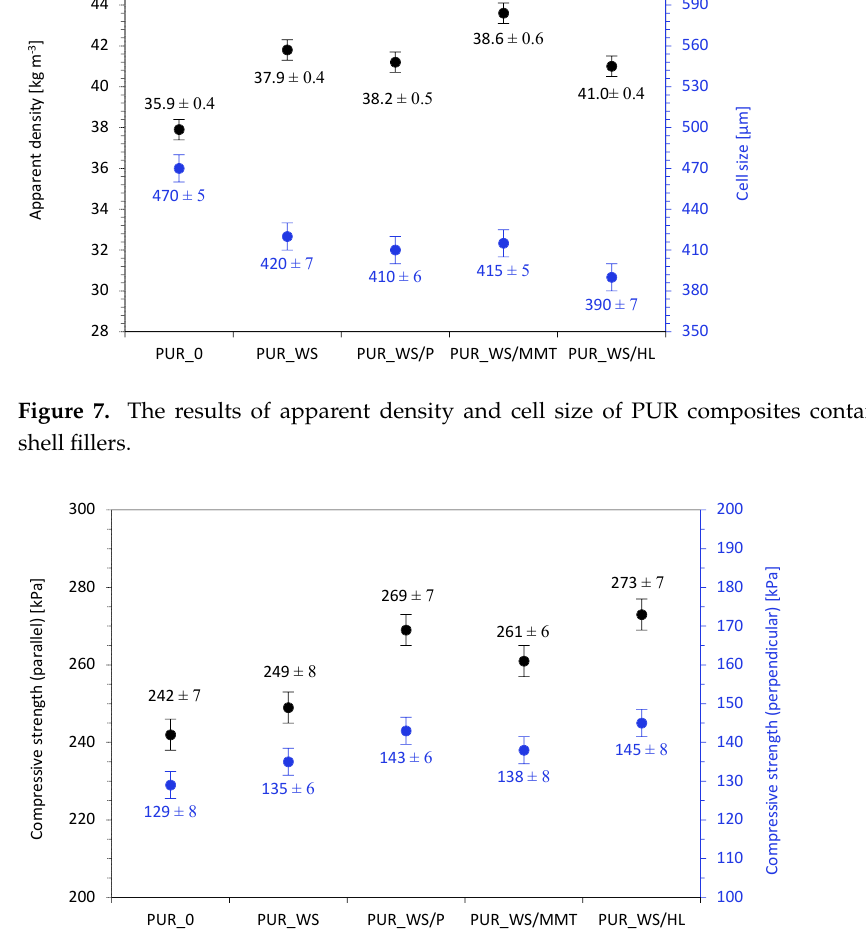
Figure 8. The impact of walnut fillers on the compressive strength of PUR foams.